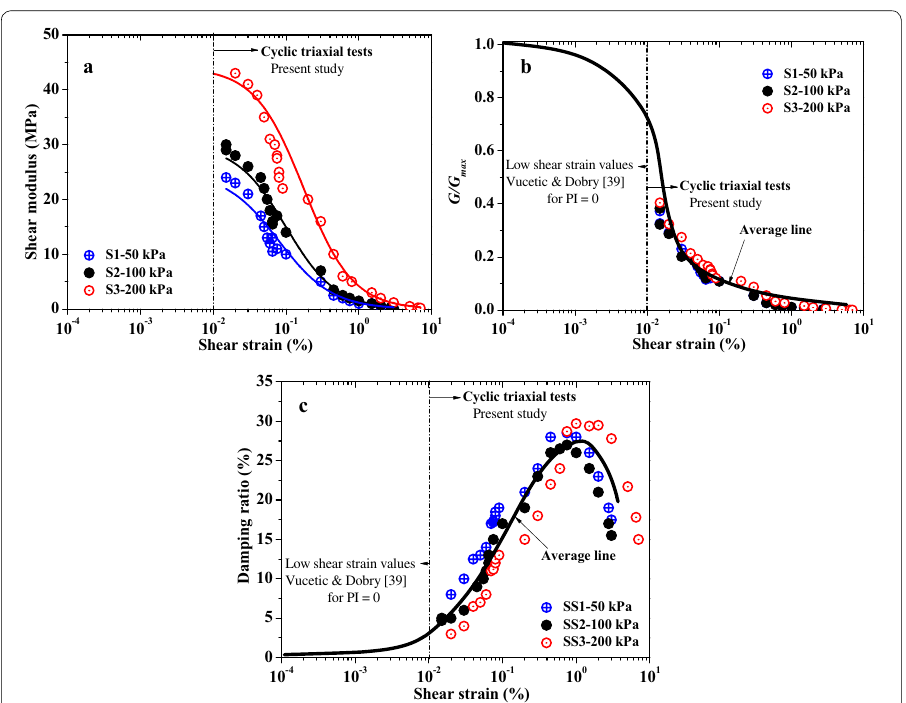
Fig. 15 Strain-dependent dynamic properties of silty-sand a G, b G/G max and c